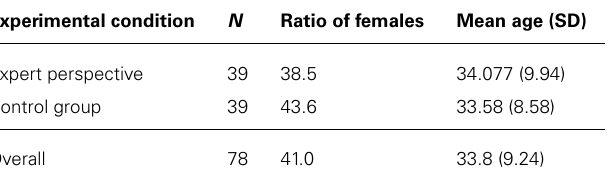
Table 1 | Information about participants in Study